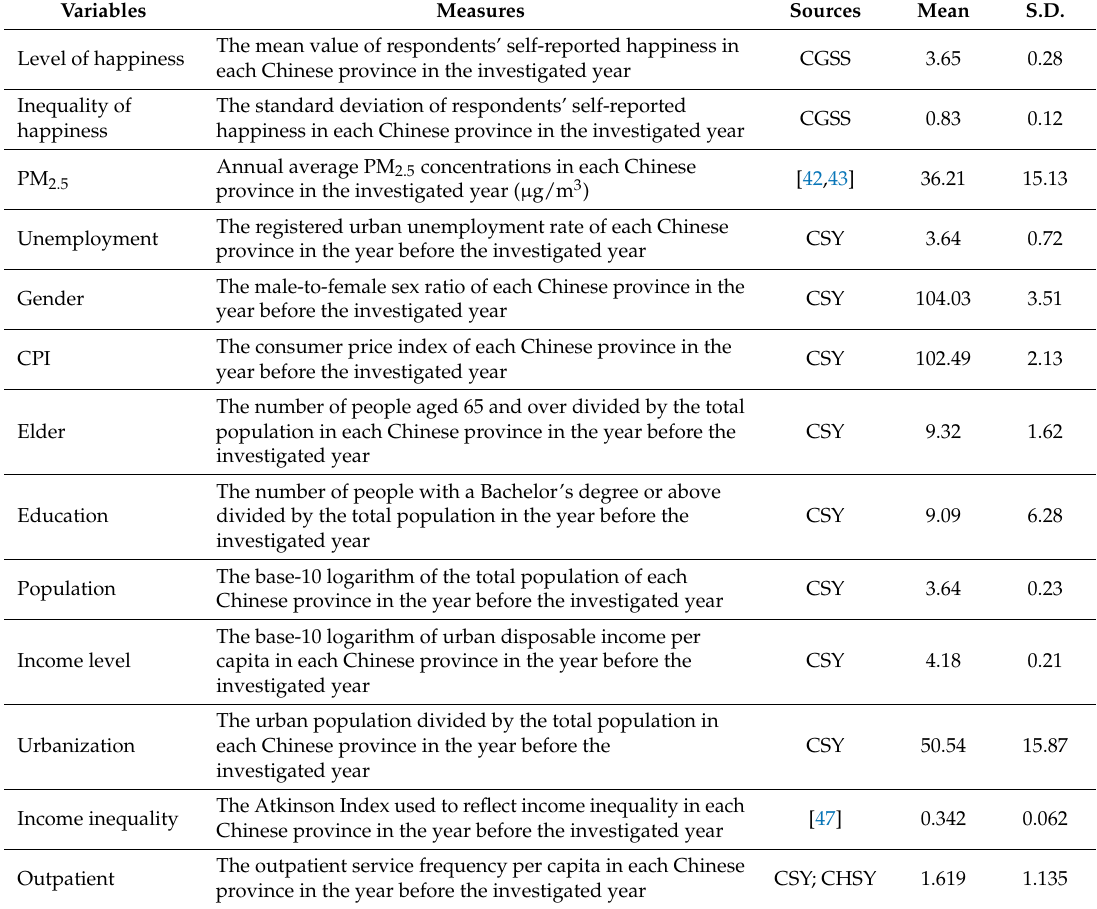
Table 1. Measures, data sources, and descriptive